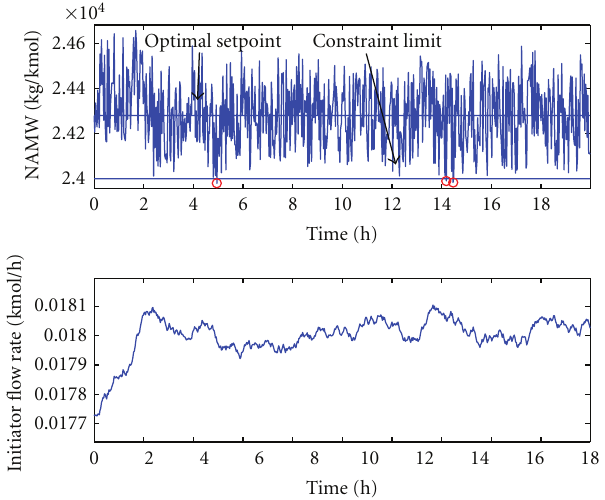
Figure 10: Improved case, optimal steady state operation point of PMMA